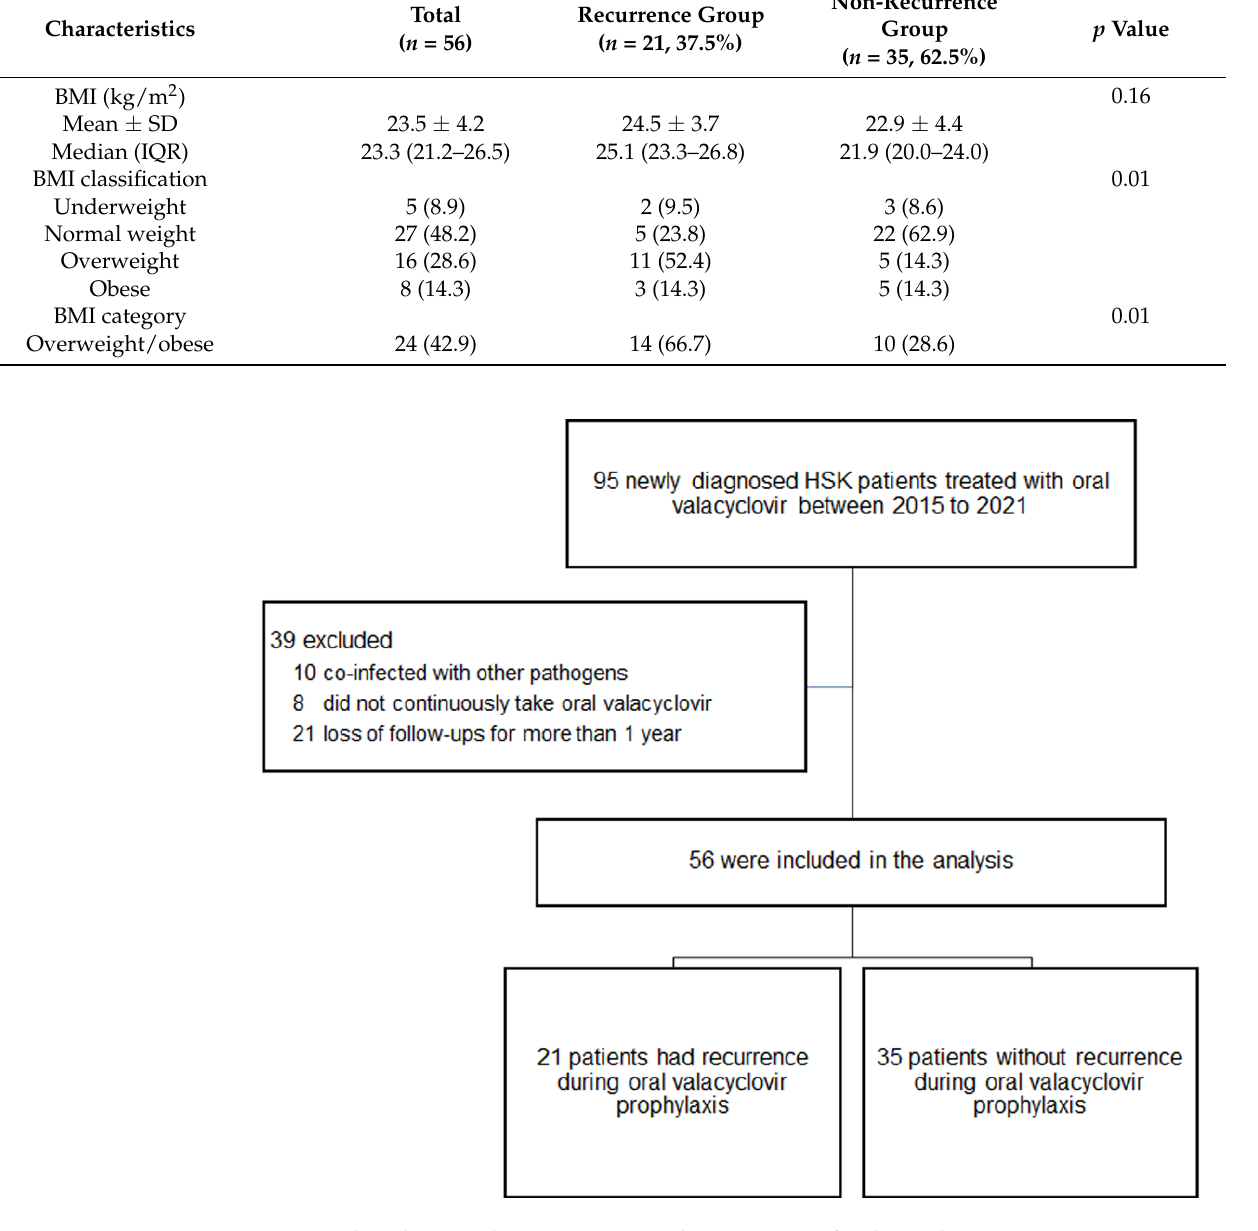
Figure 1. Flow diagram depicting patient selection process for the study.